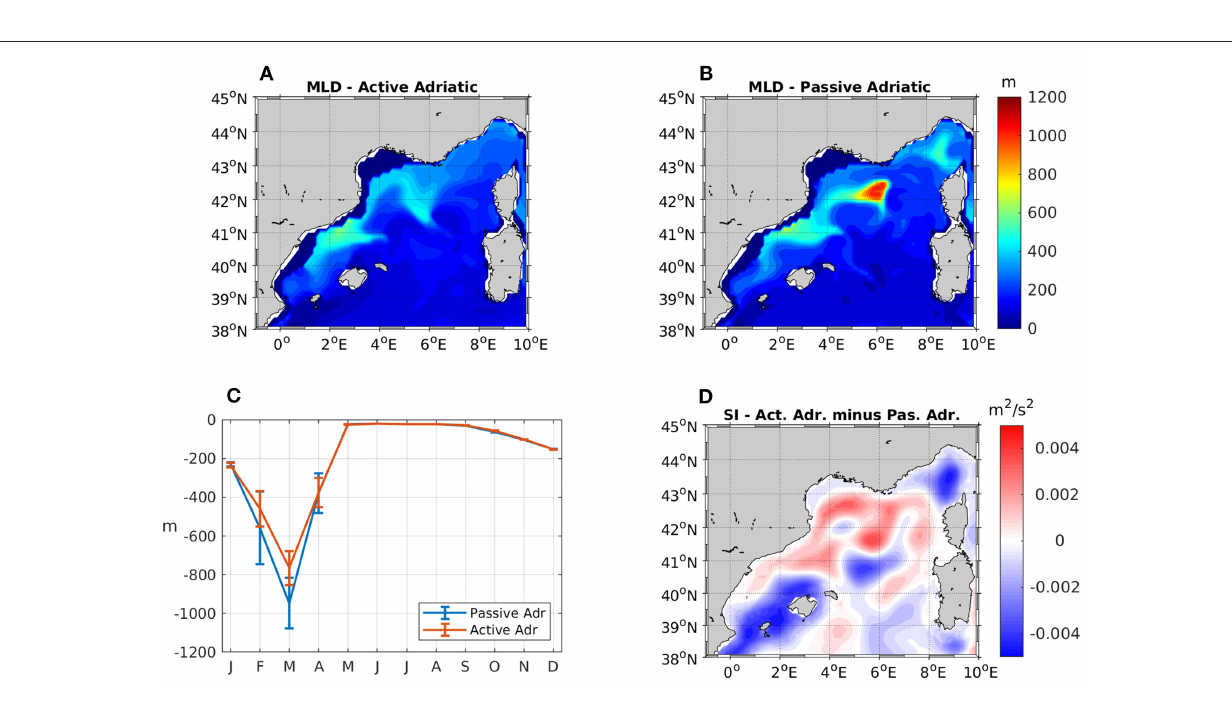
map of active Adriatic SI minus passive Adriatic SI ( Figure 6D ) emphasizes our former result that under active Adriatic there are less deep convection events in the GoL since it is more stratified than in the passive Adriatic